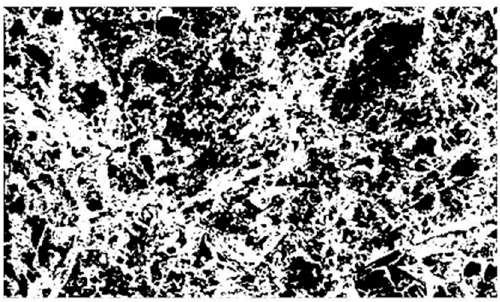
Figure 6. Image segmentation.